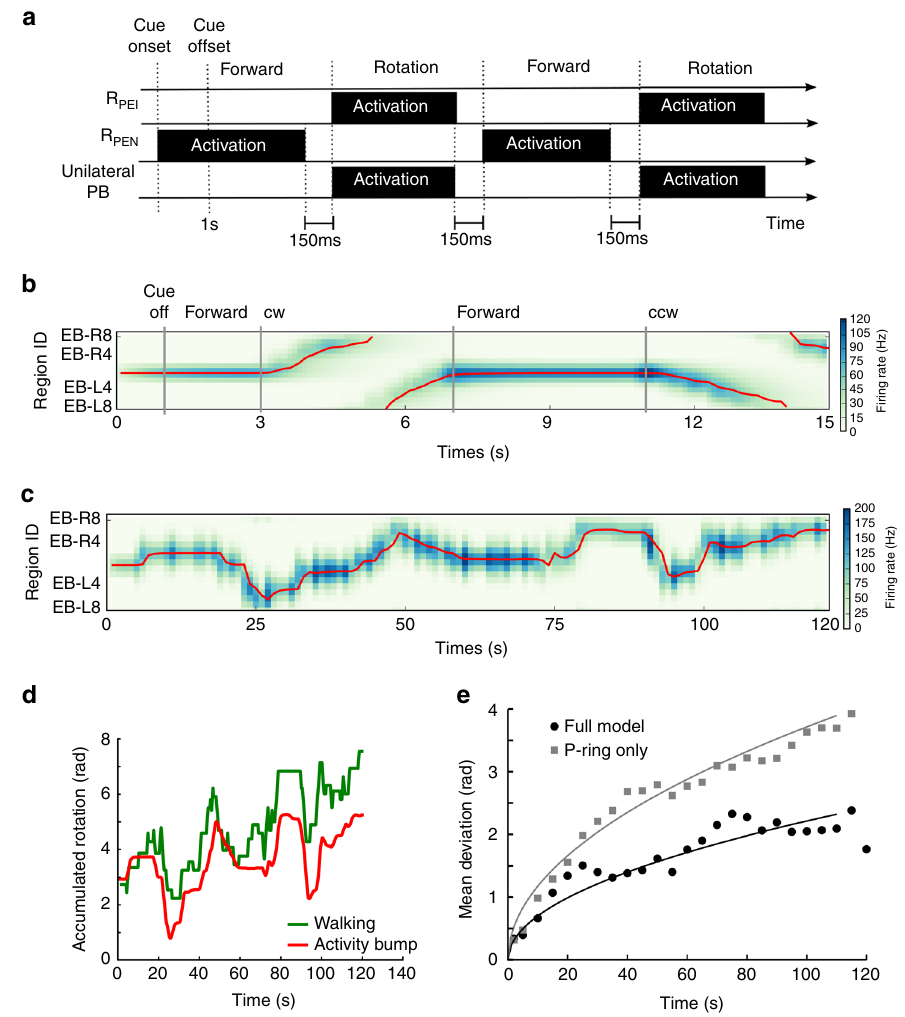
Fig. 6 The maintenance of spatial orientation memory in the full EB – PB circuit in a random walk paradigm. a A schematic of the input protocol for a random walk. A random walk consists of a sequence of interleaved periods of forward walking and rotation. During forward walking the R PEN ring neurons are activated to inhibit the P-ring, while during the rotation the R PEI ring neurons are activated to inhibit the C-ring. The PB receives a unilateral input when the simulated fl y performs a rotational movement. R EIP neurons (not shown) are activated throughout the entire trial. To allow smooth transitions between forward walking and rotation, each input has to cease 150 ms prior to the end of the corresponding movement type (see Methods). b As shown in the region-based fi ring rate plot, the full EB – PB circuit produced a stable activity bump that continuously updated its position when the body rotated in darkness. c EB activity of an example trial of a full period (120 s) of random walk in darkness (cue off at t = 1 s). d The perception of spatial orientation, as indicated by the peak position of the activity bump in EB ( red ) closely re fl ected actual fl y body orientation ( red ), though the deviation between the two increased with time. e Trial-averaged ( n = 20) deviation between the perception and actual body orientation increased with time ( black circles : the full model, gray squares : the P-ring-only model). To visualize the trends of the data, we fi t a square-root function to the data as represented by the curves. The result indicates that although the P-ring itself can track the changes of orientation, the accuracy is much worse than that of the full EB – PB